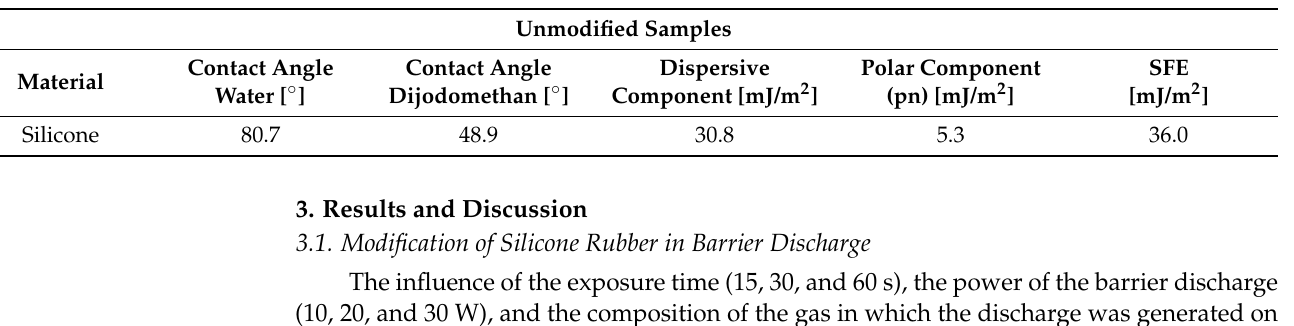
Table 1. Contact angles, polar [pn] and dispersive components, and SFE of unmodified silicone rubber.